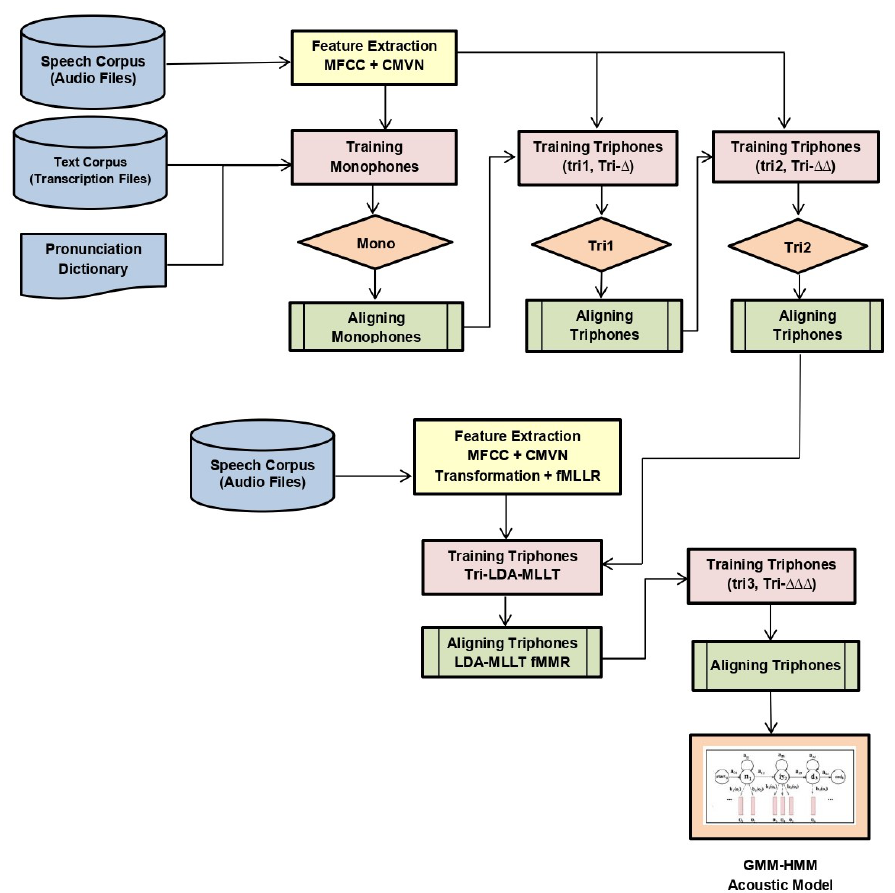
Figure 3. Model for the training of GMM-HMM. CMVN, cepstral mean and variance normalization; Tri, triphone; MLLT, maximum likelihood linear